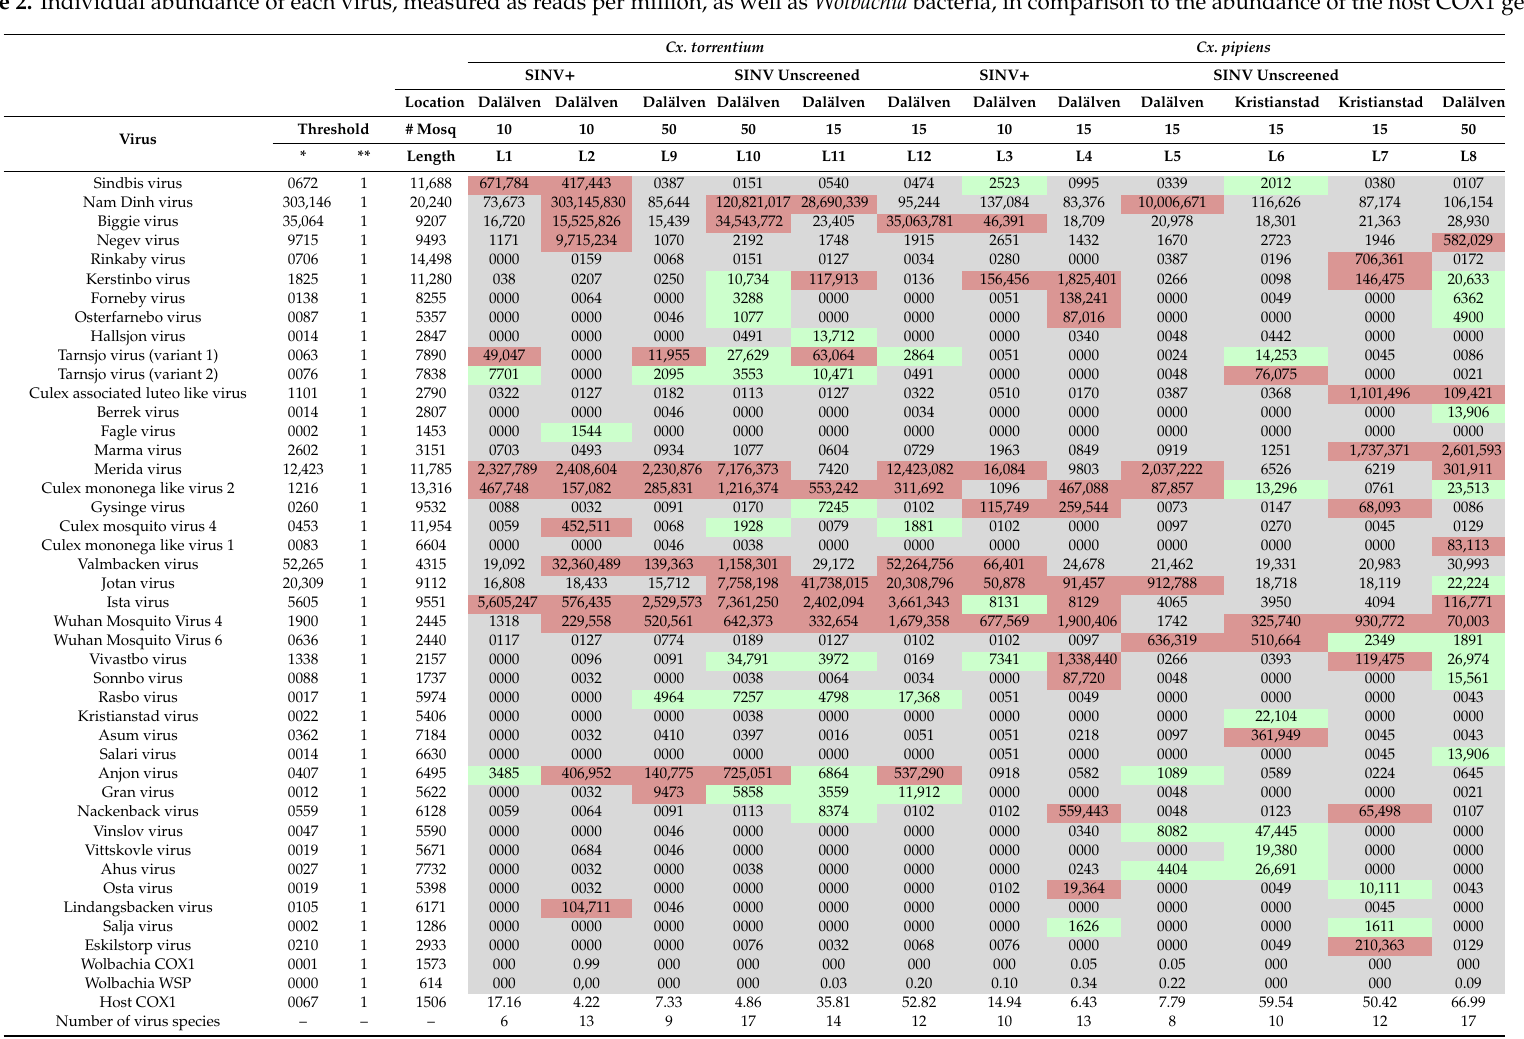
Table 2. Individual abundance of each virus, measured as reads per million, as well as Wolbachia bacteria, in comparison to the abundance of the host COX1